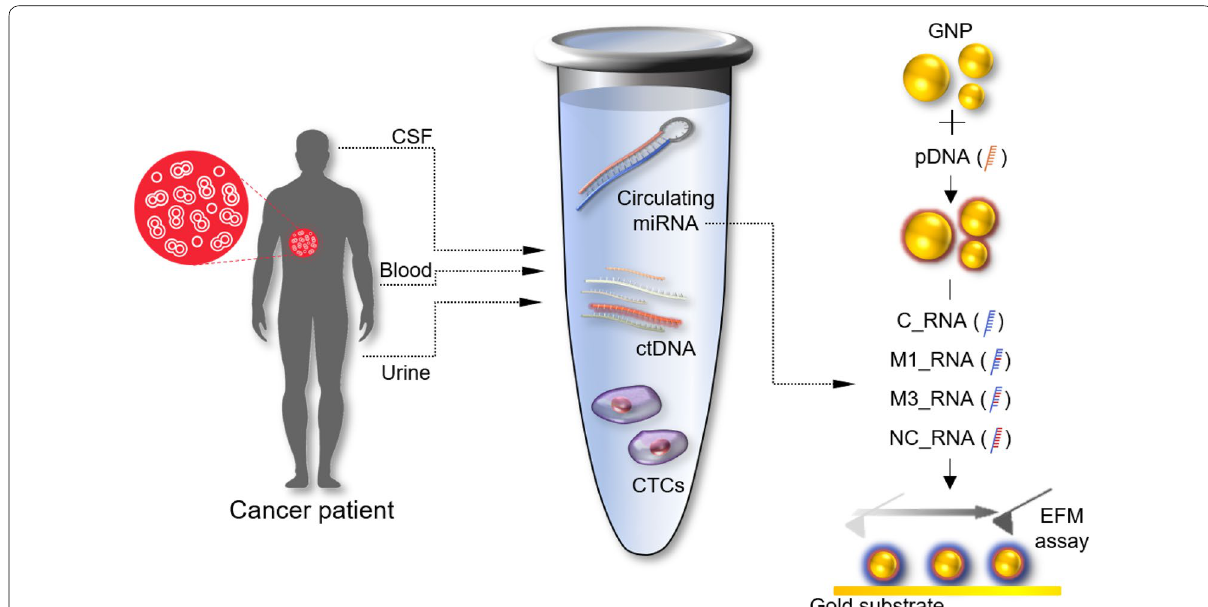
Fig. 1 Schematic representation of the assembly of DCNPs and their electrostatic force detection by EFM for liquid biopsy-based bioassay of circulating miRNA-21 (with c_RNA, M 1 _RNA, M 3 _RNA)